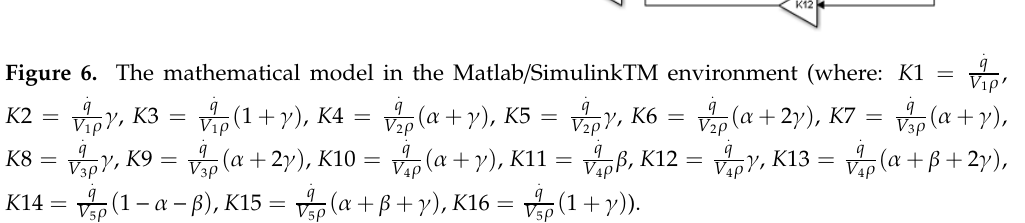
. q , , (cid:1837)2 = V 1 ρ (cid:3023) (cid:3117) (cid:3096) ((cid:2009) + (cid:2011)) , (cid:1837)8 = (cid:3044)̇ (cid:2011) , (cid:3023) (cid:3119) (cid:3096) (cid:3023) (cid:3119) (cid:3096) ((cid:2009) + (cid:2010) + 2(cid:2011)) , (cid:1837)14 = (cid:3023) (cid:3120) (cid:3096)